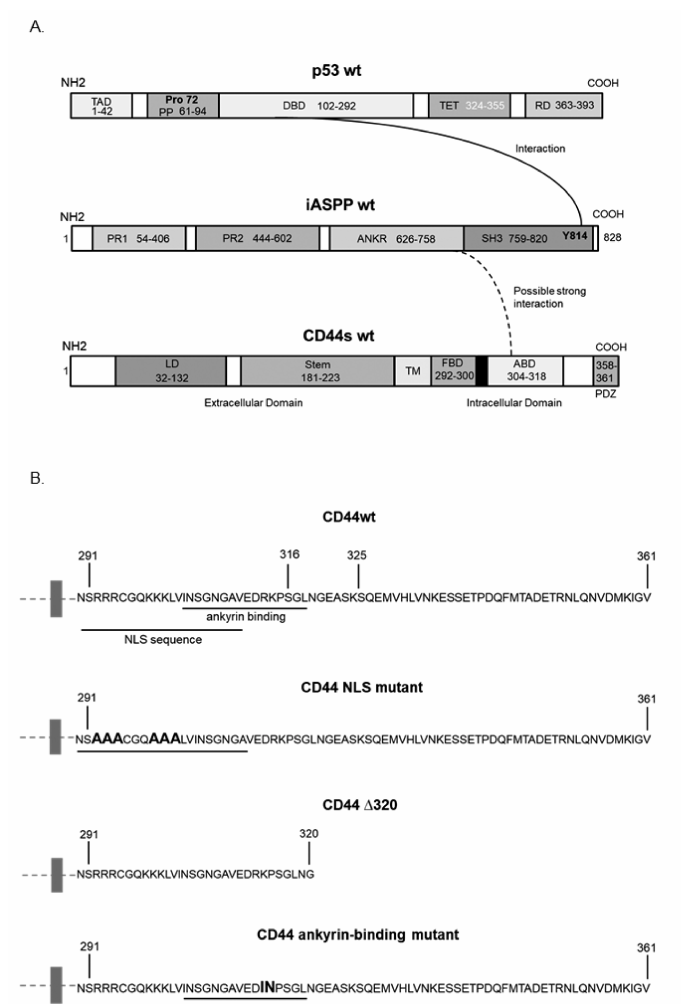
Figure 2. Schematic illustration of the structures of p53, iASPP, and CD44, and CD44 mutants. ( A ) An established interaction between domains in p53 and iASPP is indicated by a line, and the interaction found in the present study between iASPP and CD44s is indicated with a dashed line. ( B ) The cytosolic sequence of CD44 and the mutants used in this study are